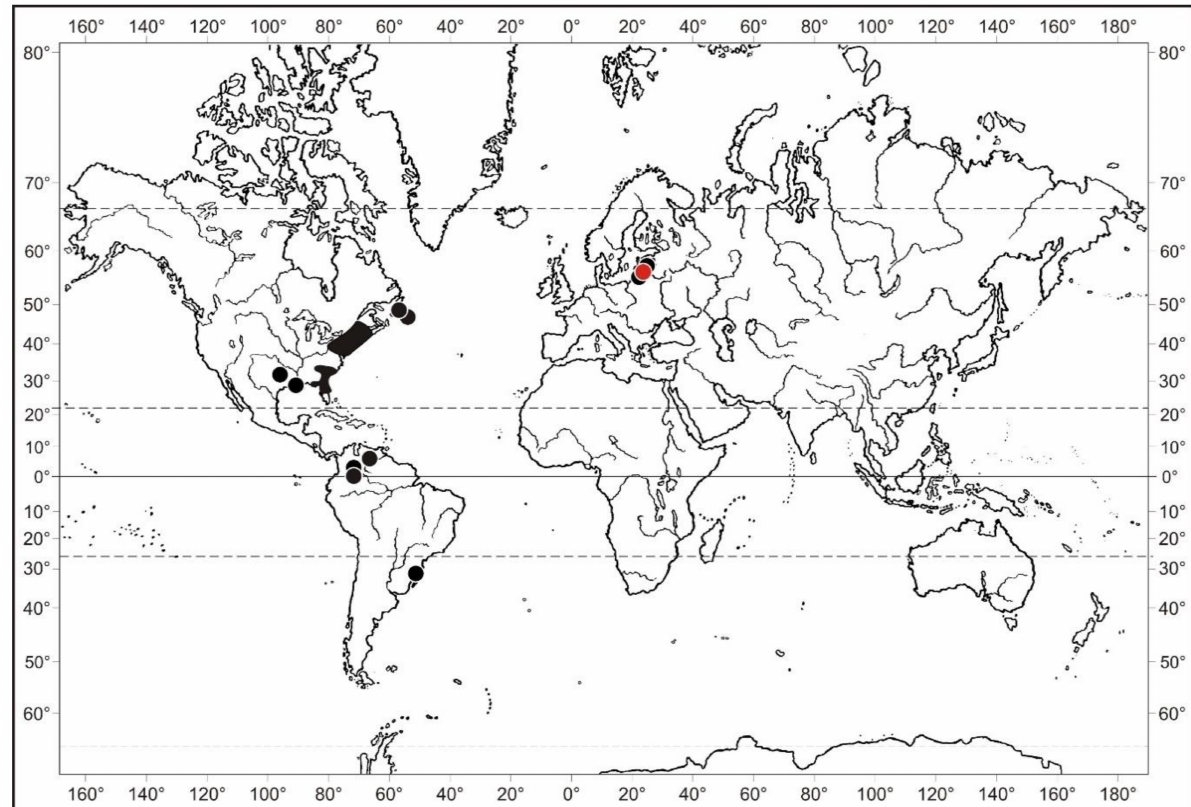
Figure 5. Global distribution map of Splachnum pensylvanicum